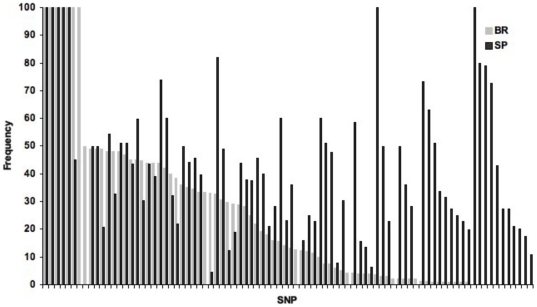
MAF distribution for each SNP at BR and SP.